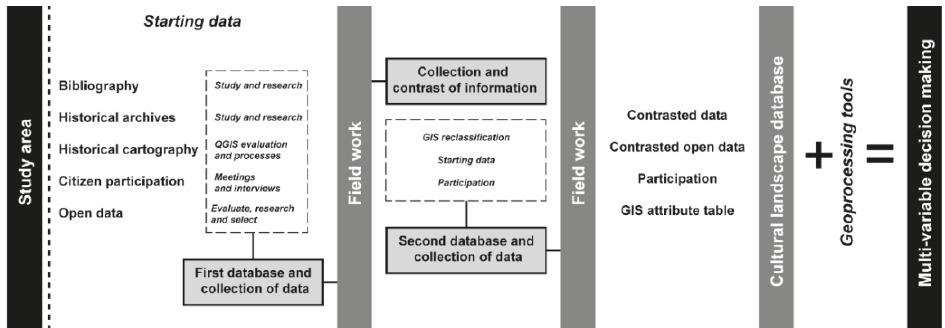
Figure 2. Flowchart of the cultural assessment procedure applied to heritage sites. All processes are described in detail in Sections 3.1 and